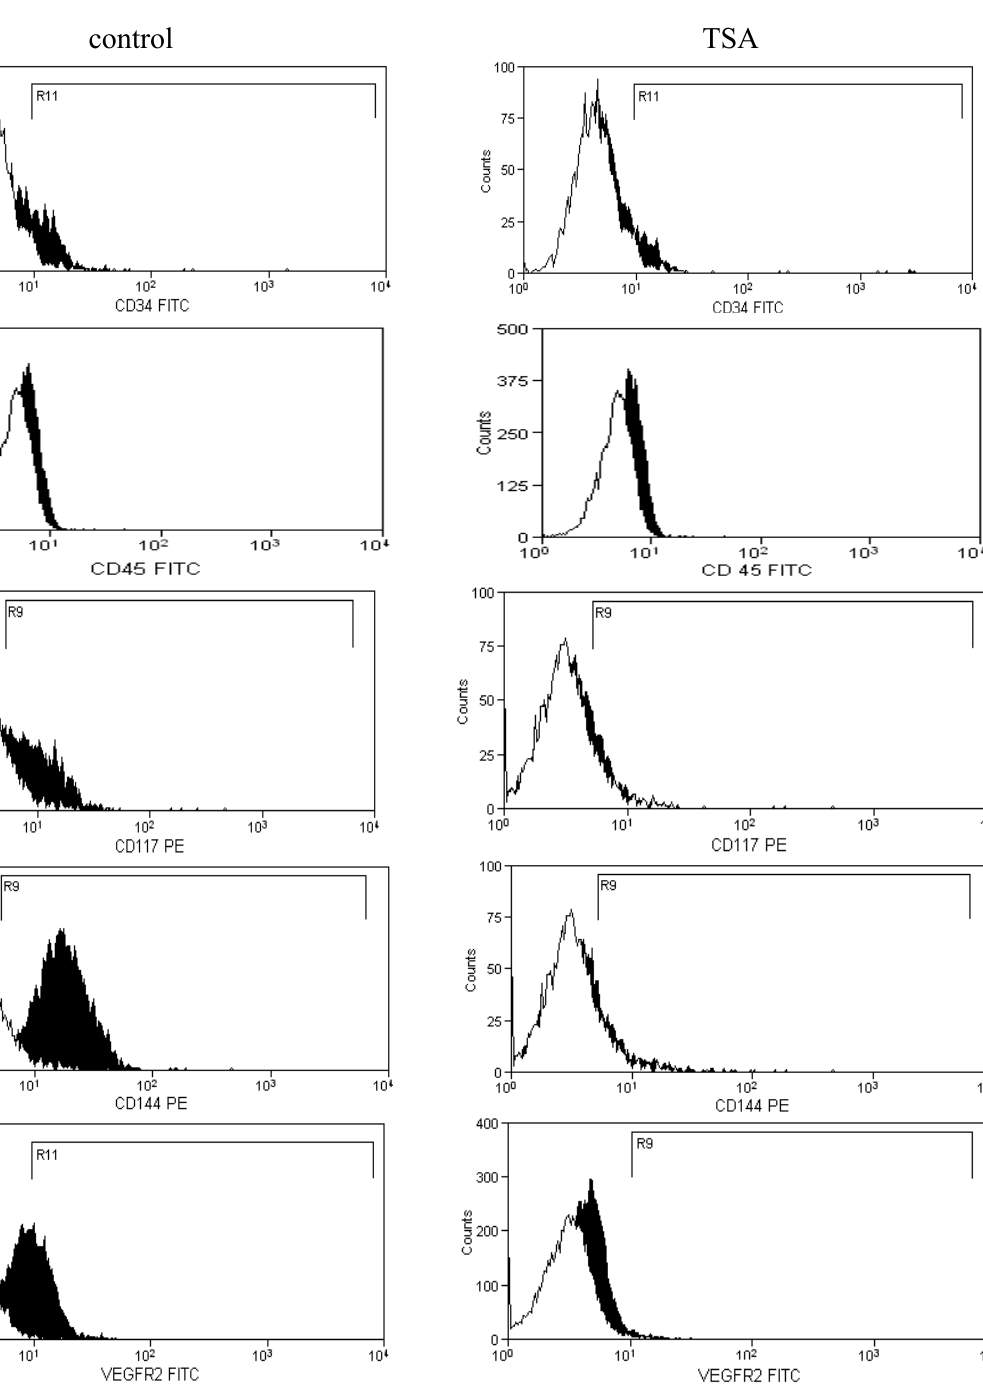
Figure 5. Flow cytometry analyses of EPCs treated with TSA (1 μ M). Immunophenotype profile shows an inhibition of CD117 (94.3%), CD 144 (93.8%) and VEGFR2 (88.2%). Results are represented as mean ± standard error, n = 3, p <